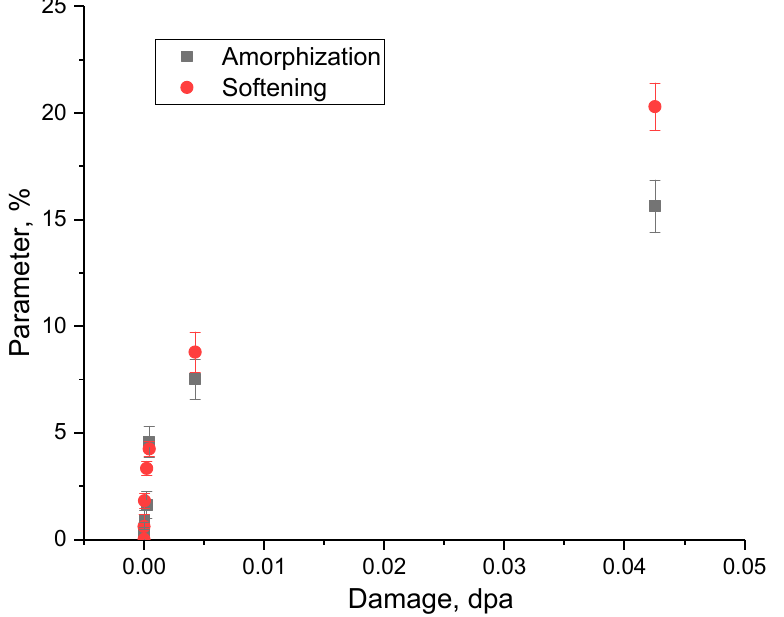
Figure 9. Correlation between changes in amorphization and softening of the damaged layer on the magnitude of atomic displacements upon irradiation with heavy Kr 15+ ions.